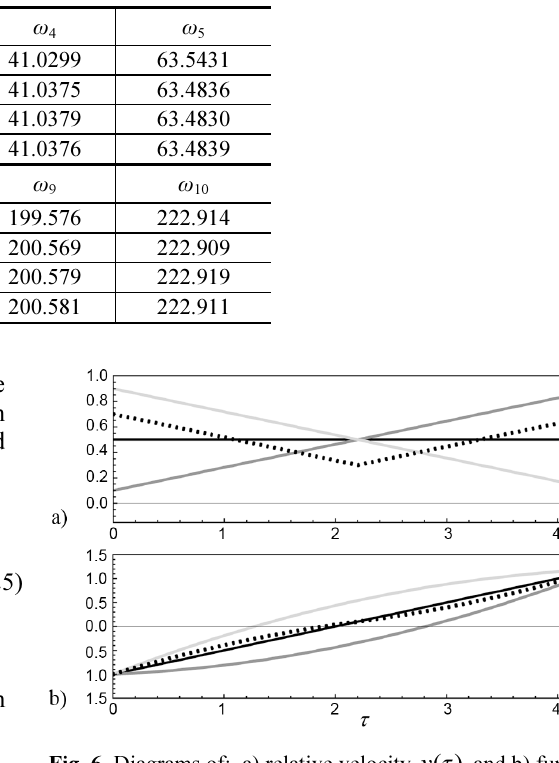
Fig. 6. Diagrams of: a) relative velocity )(